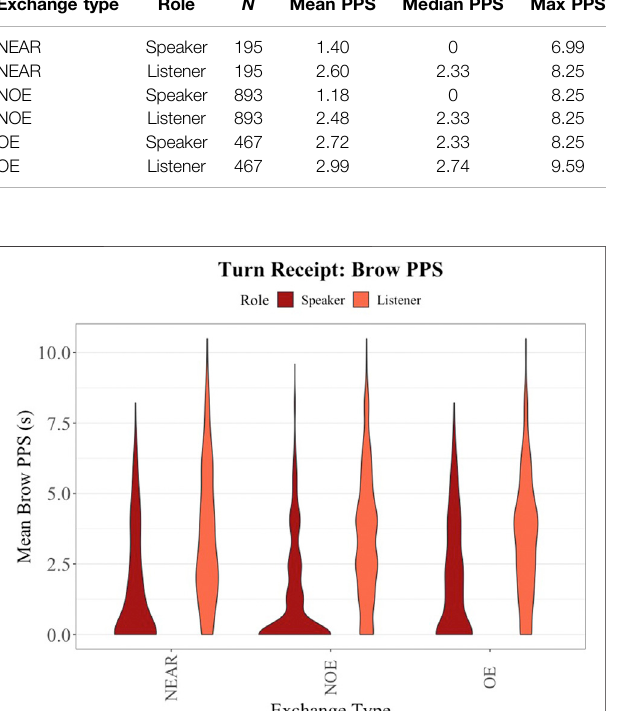
FIGURE 8 | Turn Receipt Brow PPS summary by exchange type and role.